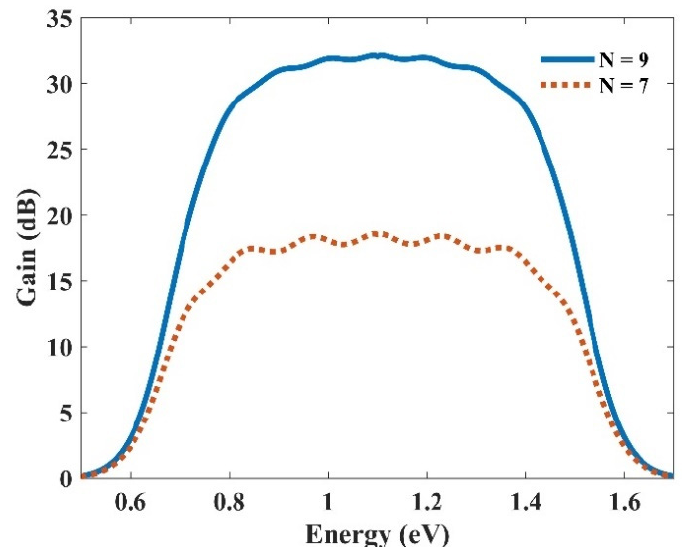
Figure 11. Ultra-wideband optical gain, obtained by superimposing seven and nine groups of QDs.